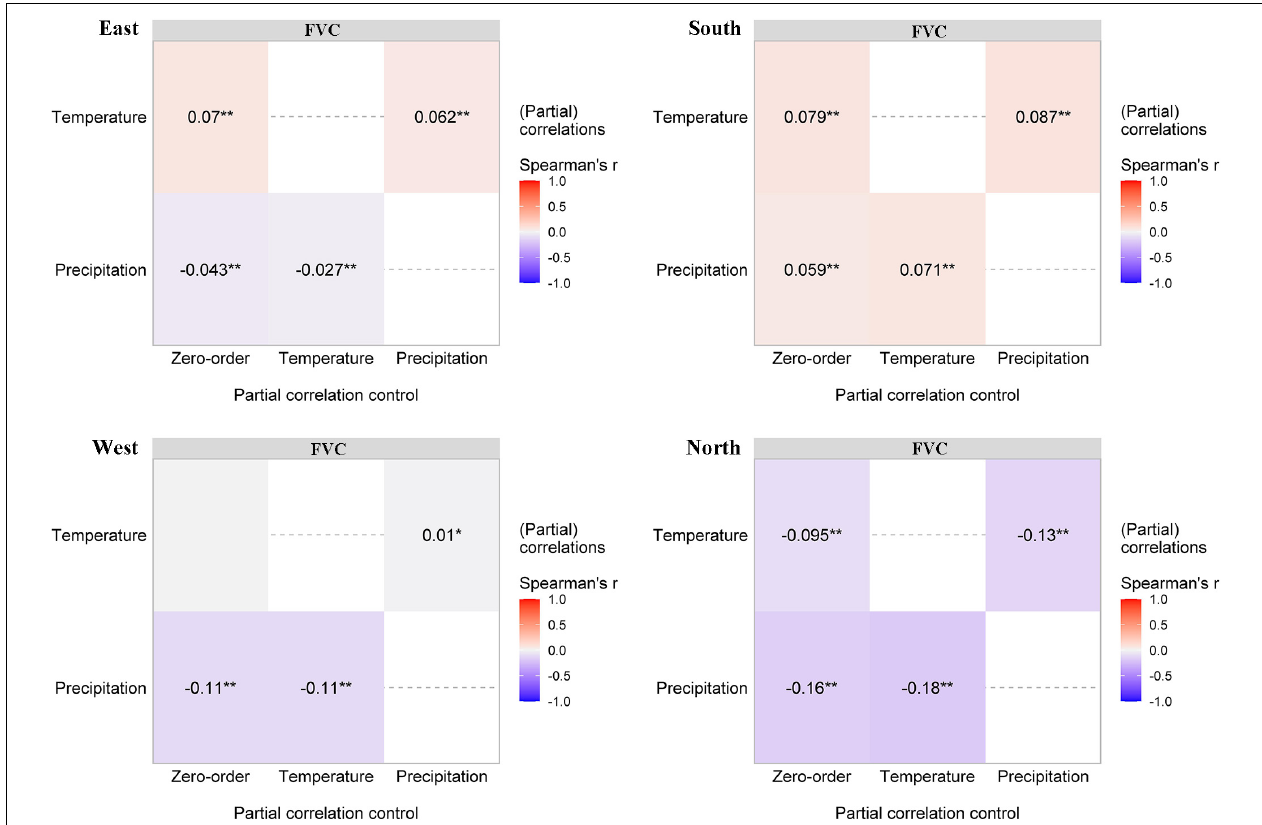
FIGURE 8 | Partial correlations (Pearson’s r ) between fraction vegetation cover and the two climatic variables. The intensity of colors and numbers indicate the strength of the correlation. Significant levels are: * P < 0.05; ** P < 0.01.